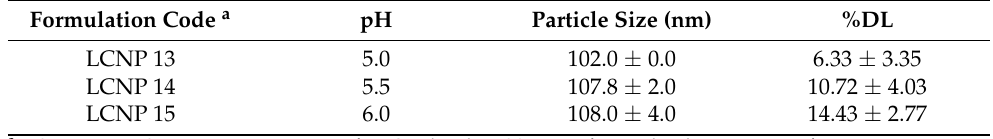
Table 4. Effect of pH of CS solution on the particle size and %DL of RTG-LCNP. Formulation Code